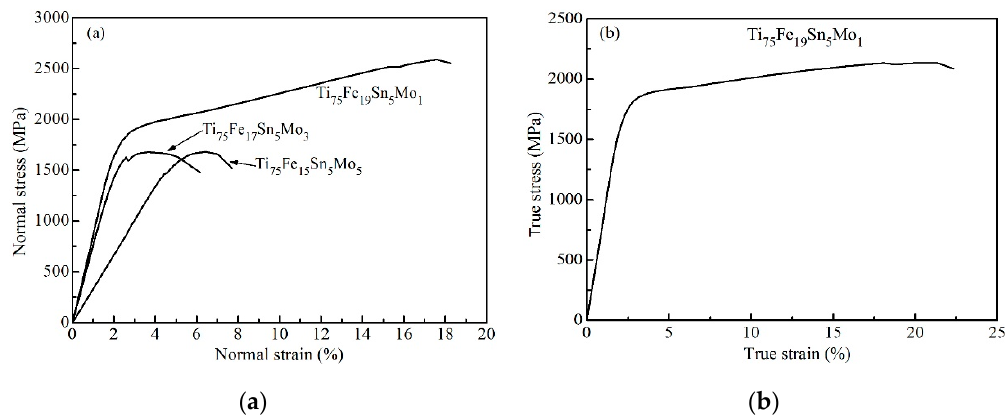
Figure 5. The ( a ) normal and ( b ) true stress–strain curves of the Ti–Fe–Sn–Mo alloys. As the density of Mo element (10.22 g ⋅ cm − 3 ) is larger than that of Fe element (7.86 g ⋅ cm − 3 ), when